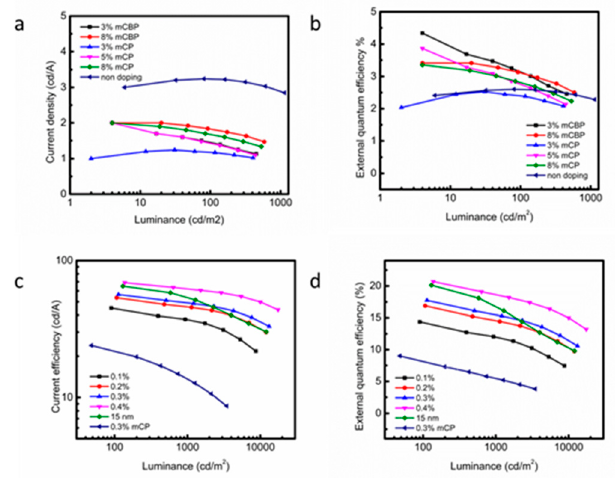
Figure 4. ( a – b ) CE- L and η EQE - L curves of deep-blue devices; ( c – d ) CE- L and η EQE - L curves of white devices. Table 2. Summary of electroluminescence data for organic light-emitting diodes (OLEDs).